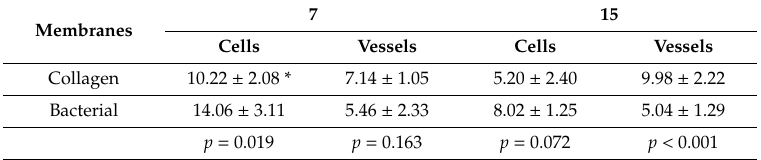
Table 1. Table demonstrating the average and standard deviation for inflammatory cells and vessels for each group (BG and BC) at postoperative 7 and 15 days. p -values for intergroup comparison.